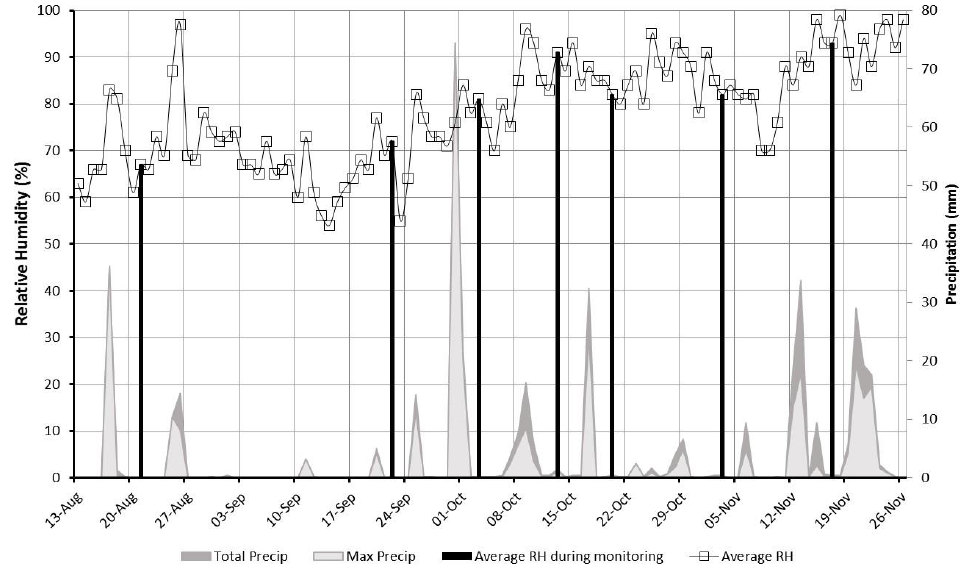
Figure 2. Relative humidity and precipitation at Casa Rota Landfill during the monitoring period.